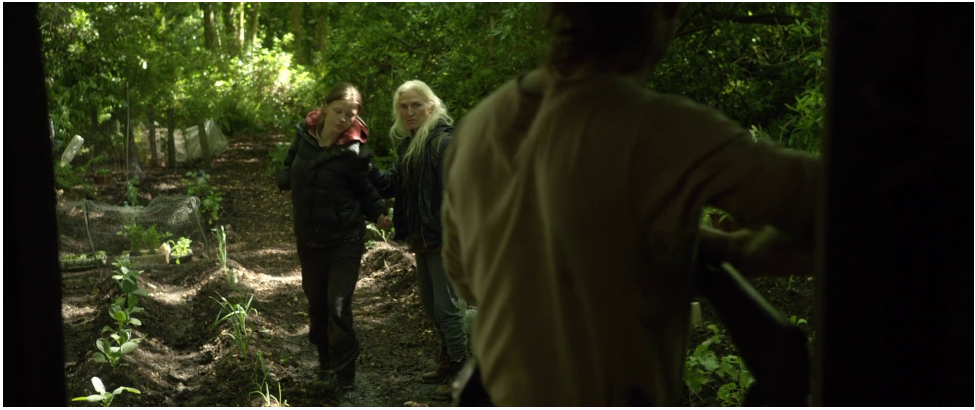
Figure 1: Hostile hospitality: the Survivalist welcomes his guests, Kathryn and Milija, with a cocked